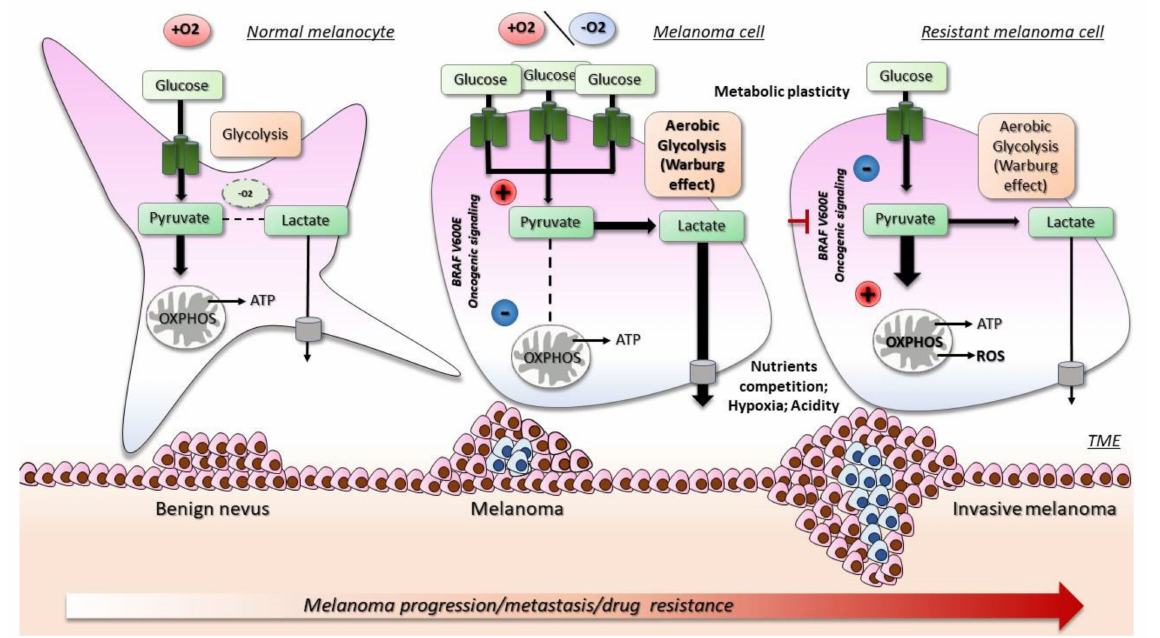
Figure 1. Metabolic plasticity in melanoma. In normal melanocyte, the energetic metabolism, in the presence of oxygen (O2), starts from the consumption of glucose via glycolysis to the final production of adenosine triphosphate (ATP) mainly via oxidative phosphorylation (OXPHOS). During the development of the tumor, the metabolic pathways drastically change. In melanoma cells, the BRAF-mutated oncogenic pathway, leading to the over-activation of MAPK, sustains mainly aerobic glycolysis/Warburg phenotype with secretion of lactate. Inhibition of MAPK pathway decreases glycolysis, leading to a dependence on mitochondrial metabolism with increased production of reactive oxygen species (ROS). This phenotype switch is a metabolic adaptation mechanism developed by cells to survive under drug’s pressure and is a common feature of melanoma cells resistant to targeted-therapy. Intrinsic (mutations, intracellular pathways) and extrinsic factors (nutrients, O2 levels, acidity, and soluble factors) can contribute to increase the metabolic plasticity of melanoma cells selecting subclones with a different metabolic phenotype. The progressive metabolic reprogramming in melanoma is accompanied by a drastic increase in tumor aggressiveness. +: positive regulation; − : negative